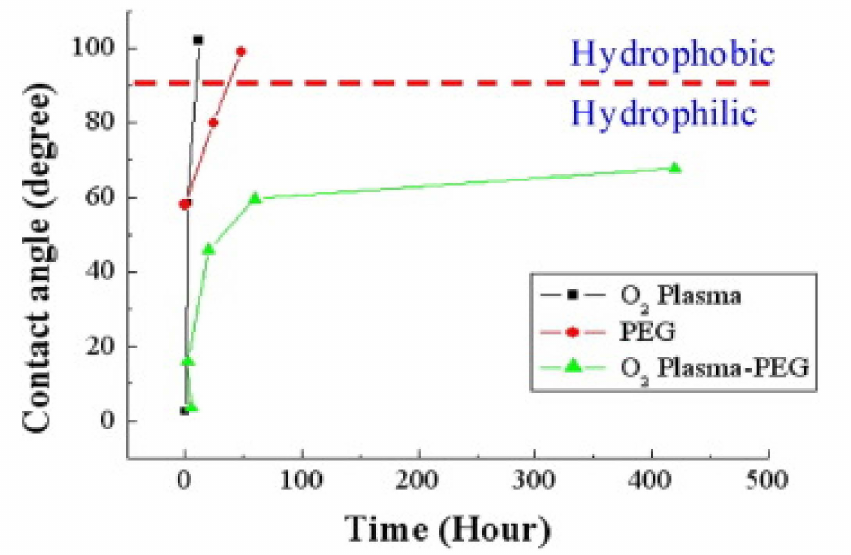
Figure 11. The contact angle is a function of the retaining time of PDMS after different treatment methods i.e., the O 2 plasma, the PEG, and the O 2 -plasma-PEG